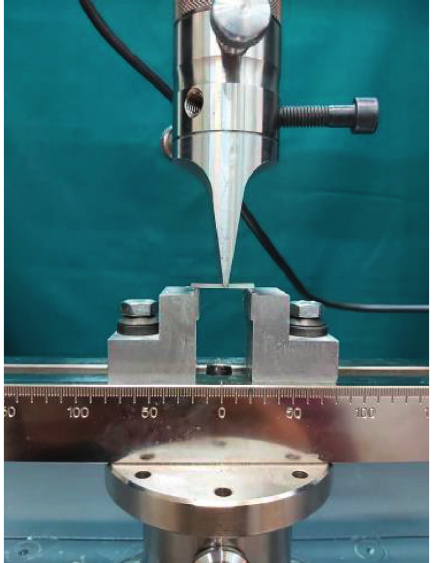
Figure 2: Testing the flexural strength through three-point bend